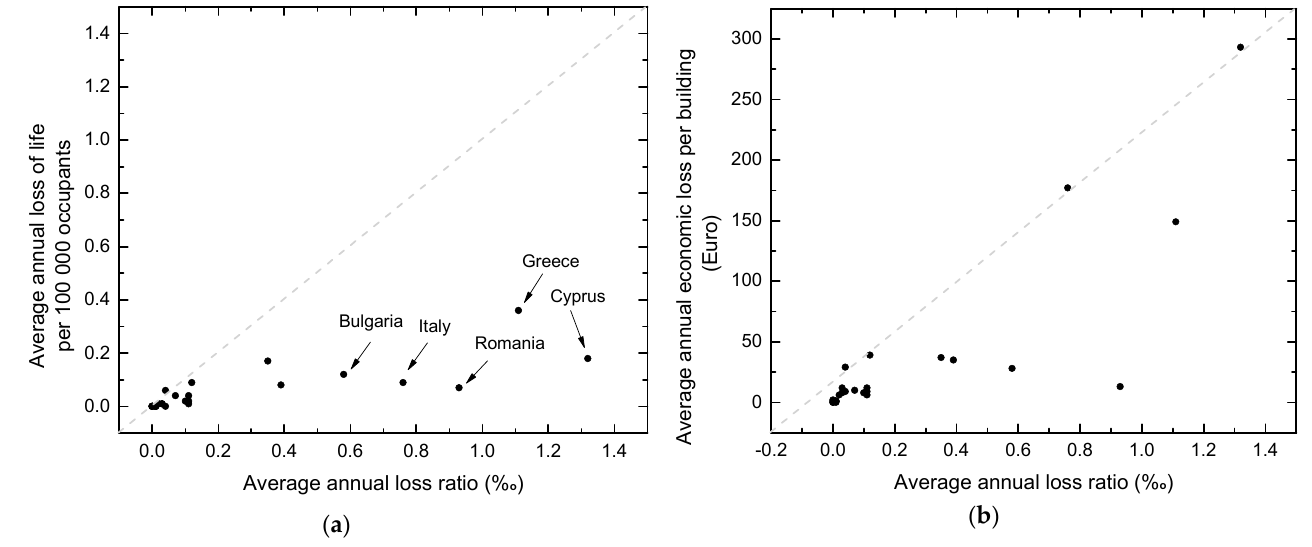
Figure 6. ( a ) Comparison between AALL and AALR; and ( b ) AAEL per building and